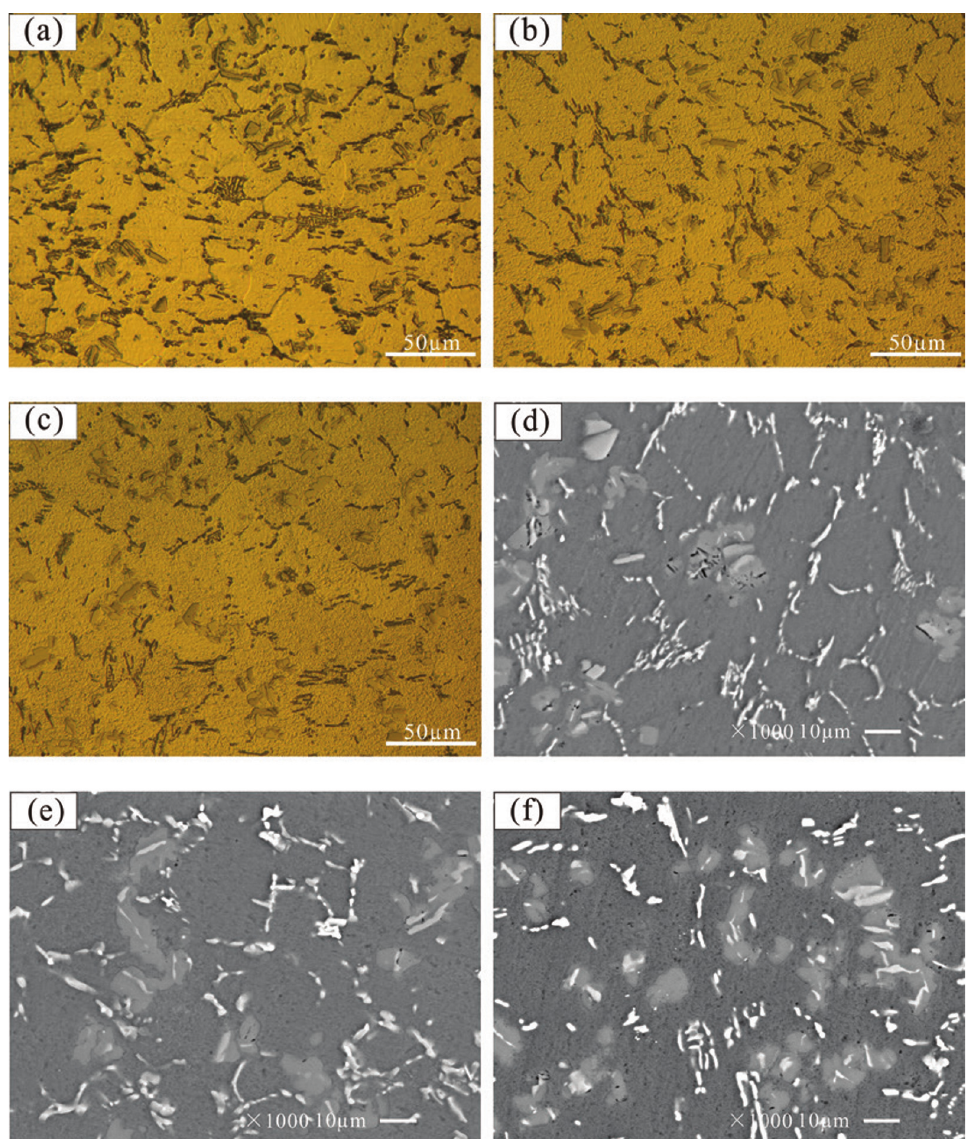
Fig. 2: OM microstructures of alloy 2618-Ti homogenized at different temperature for 24 h: (a) 450 °C, (b) 460 °C, (c) 500 °C; and BSE images at 500 °C for different time: (d) 12 h, (e) 24 h, (f) 12